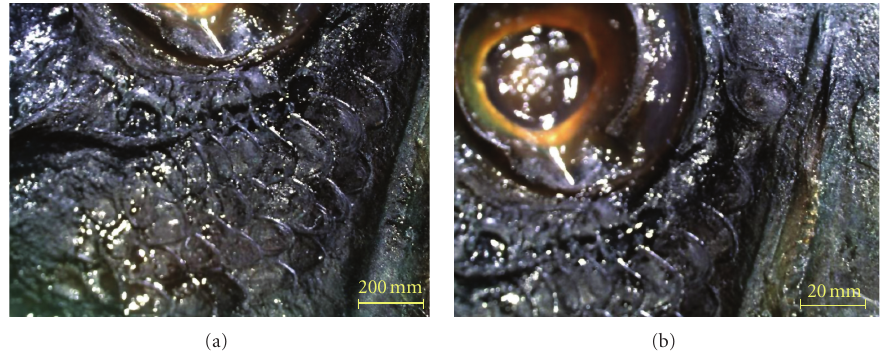
Figure 4: (a) Rows of scales on cheek. (b) Rows of scales behind eye.